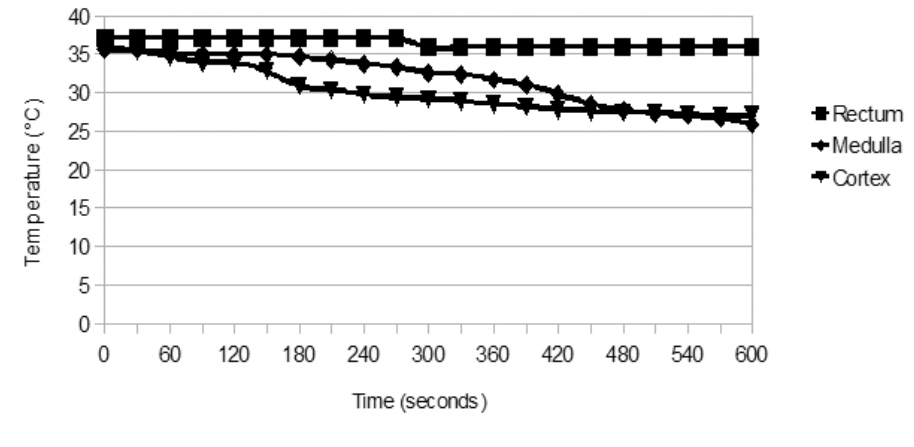
Figure 3A - Temperature versus infusion time with hilar clamped (infusion rate = 600 cc/hour).